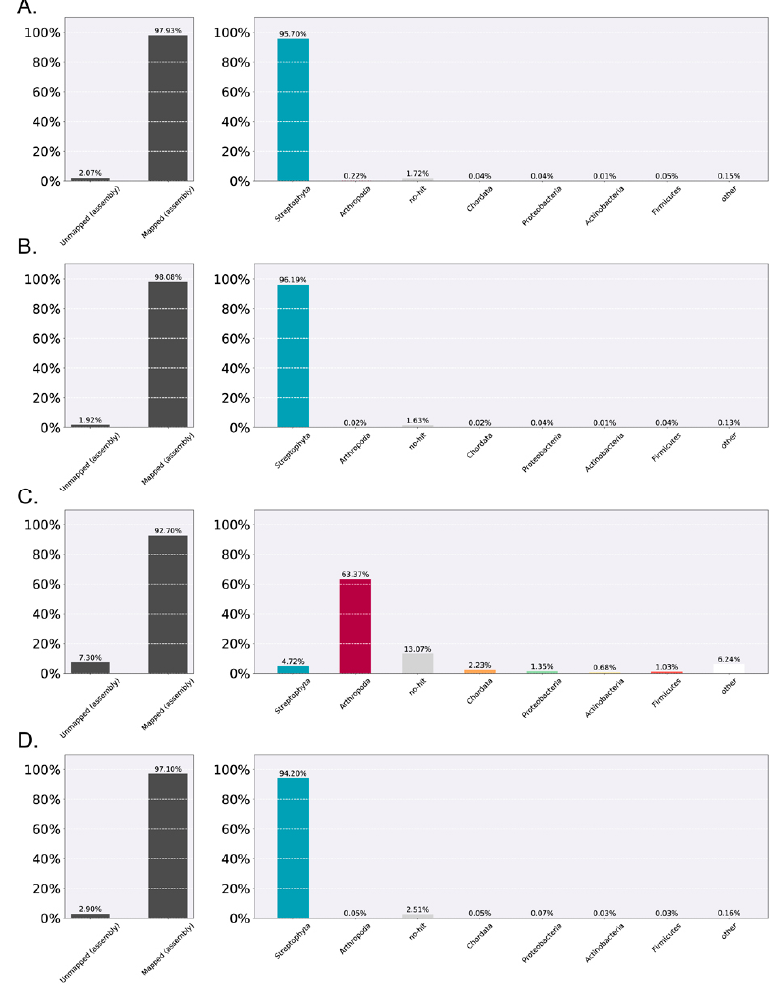
Figure 2. Transcript taxonomy annotation summary as determined by blobtools and BLASTX searches of the NCBI nr database.